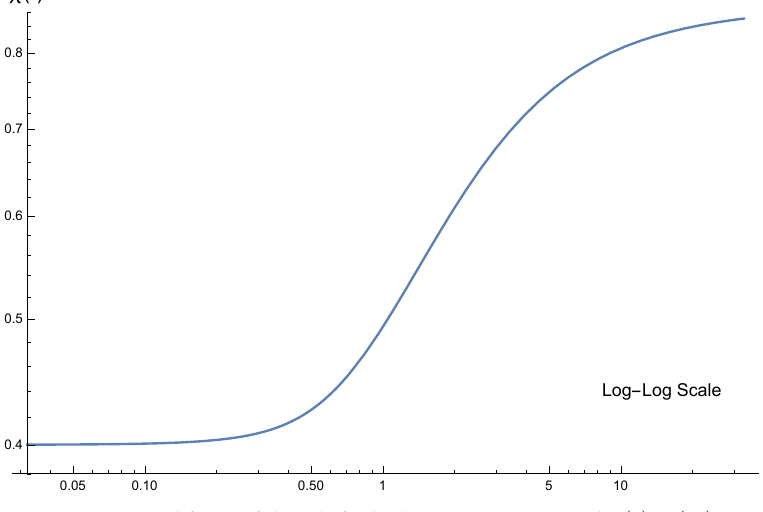
Figure 2. Typical form of the (shifted) electrostatic potential χ ( r ) , χ ( ∞ ) = ω .